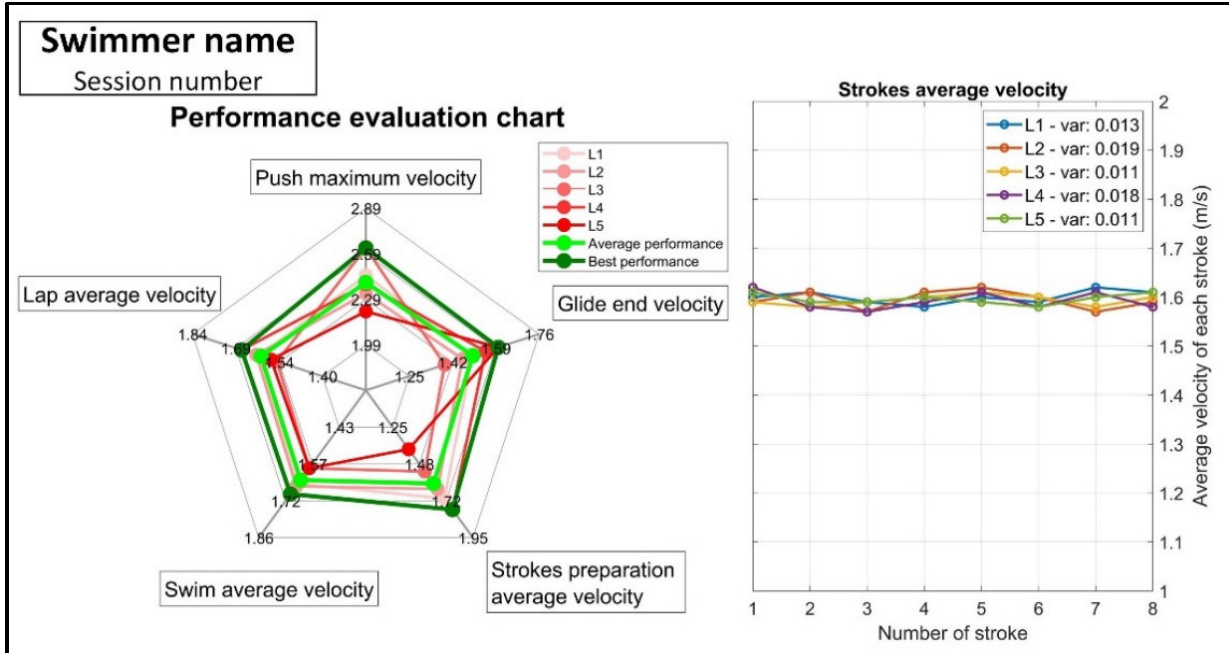
Figure 2. Individual feedback for the swimmer after the test session. The performance evaluation chart ( left ) shows the goal metrics for five laps, the average performance (light green) and the best performance (dark green). The stroke average velocity chart ( right ) shows the average velocity per stroke during five laps and its variation (“var”, corresponding to standard deviation) in the legend.